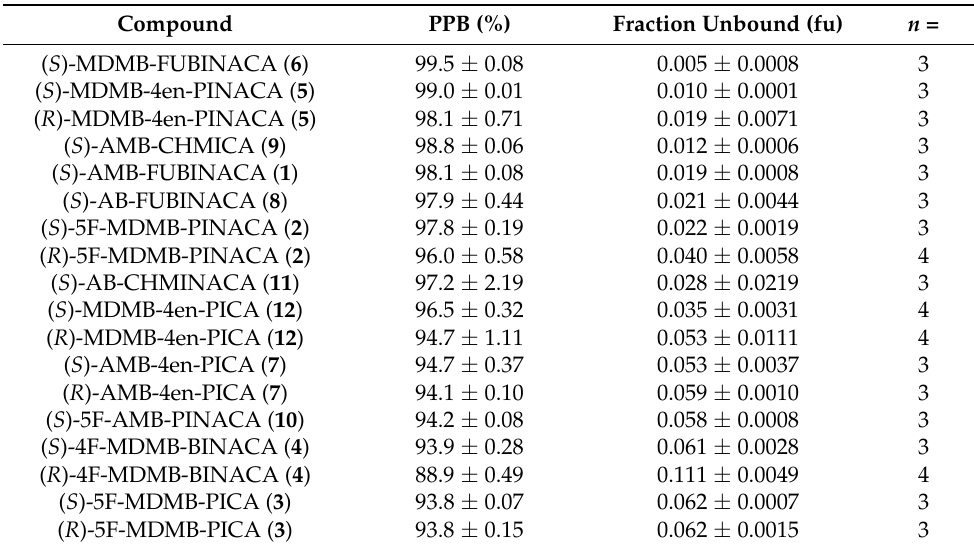
Table 3. Plasma protein binding (PPB) of tested SCRA